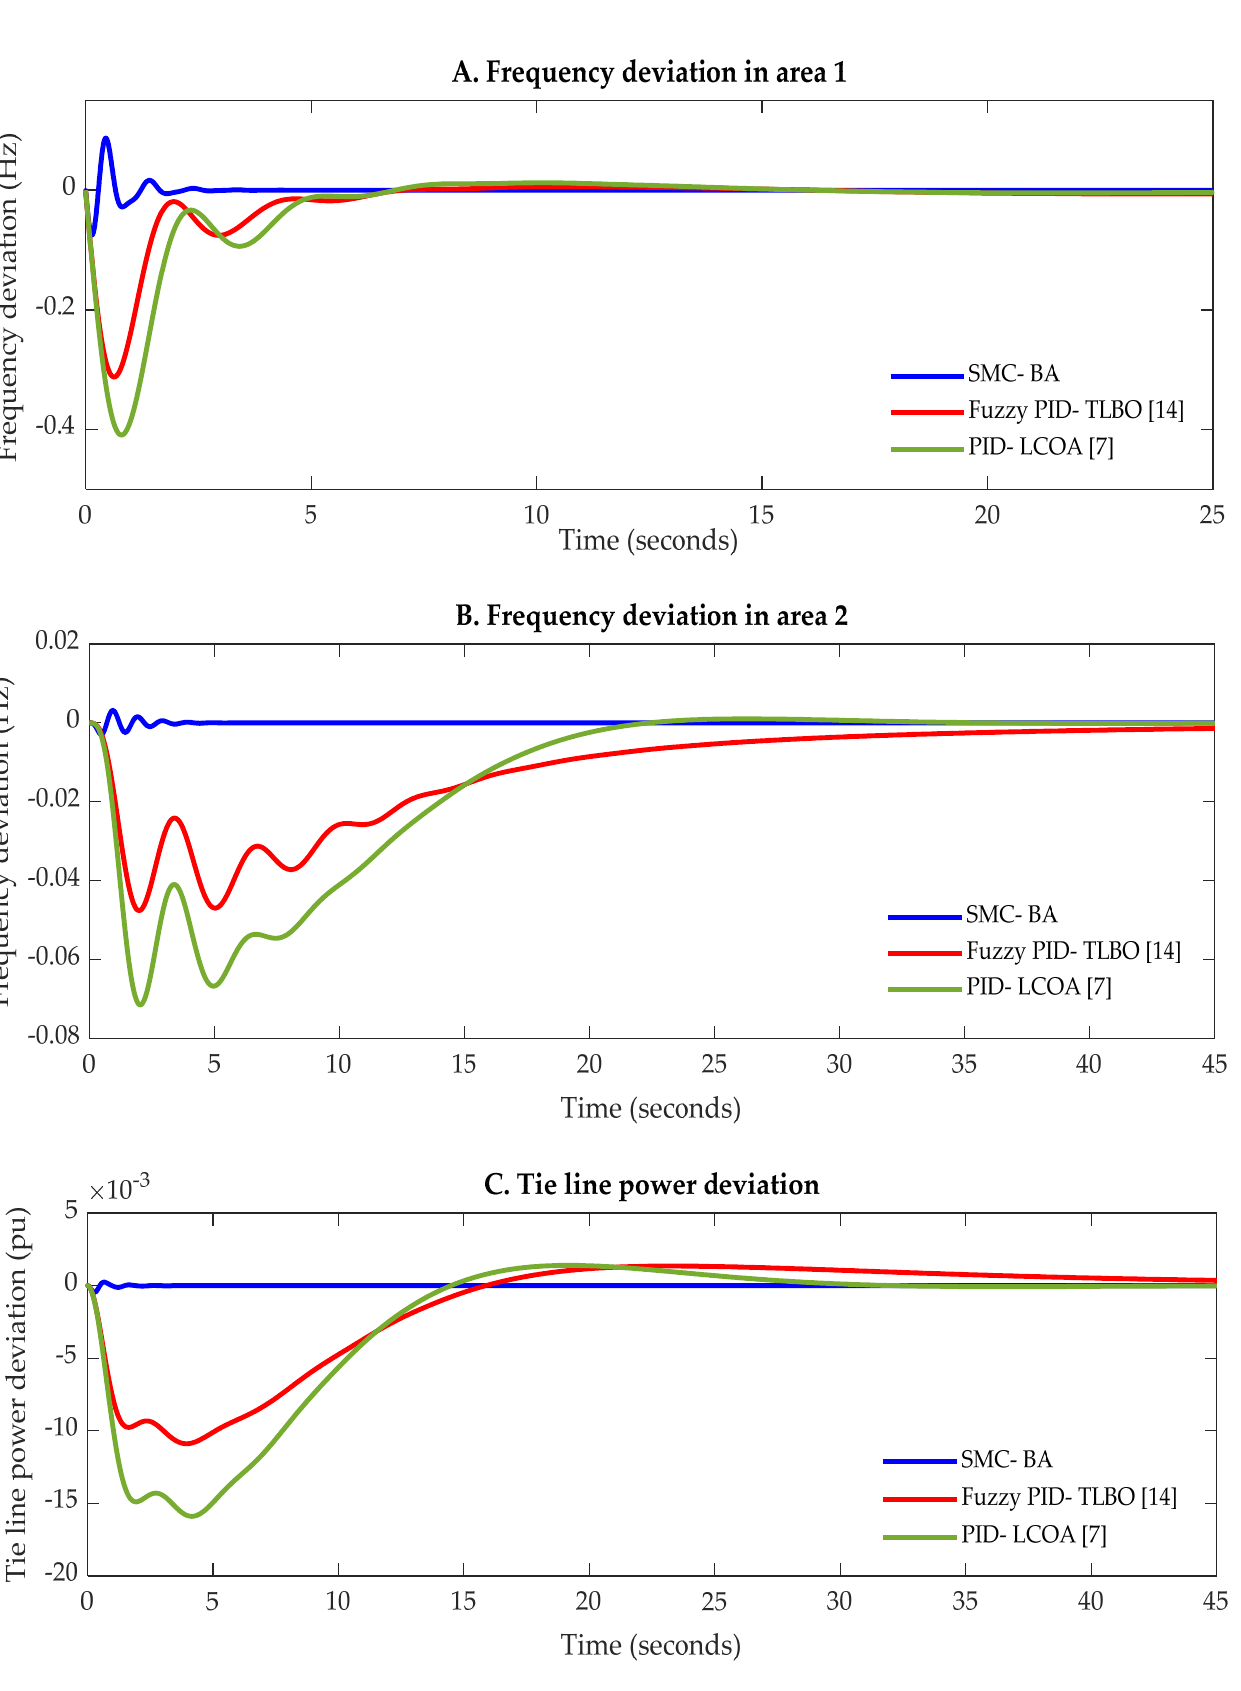
Figure 16. Dynamic response of the system with different controllers under parametric uncertainties, case 10. ( A ) Frequency deviation in area 1; ( B ) Frequency deviation in area 2; ( C ) Tie line power deviation.